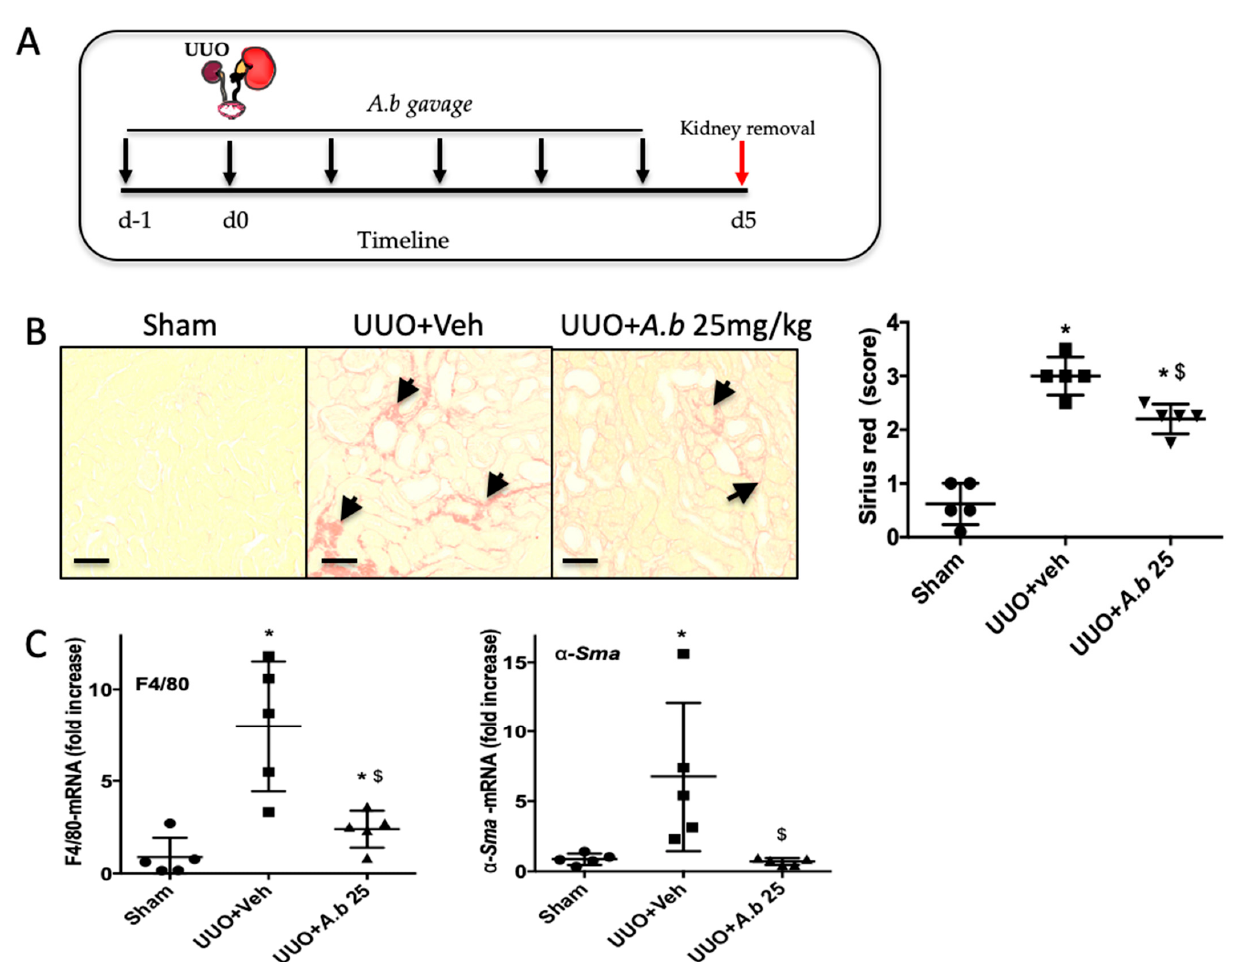
Figure 2. Preventive effect of A. borbonica ( A. b ) 25 mg/kg on renal tubulointerstitial fibrosis induced by unilateral ureteral obstruction (UUO) in mice. ( A ) Experiment design: black arrows indicate daily gavage with 25 mg/kg A. b. ( B ) Renal tubulointerstitial fibrosis highlighted with the Sirius red staining, arrows indicate interstitial fibrosis. ( C ) qPCR analyses of mRNA–macrophage infiltration (F4/80) and myofibroblasts ( α -Sma ); n = 5 per group. * p < 0.05 compared to Sham; $ p < 0.05 compared to UUO + Veh. Scale bar =100 µm.